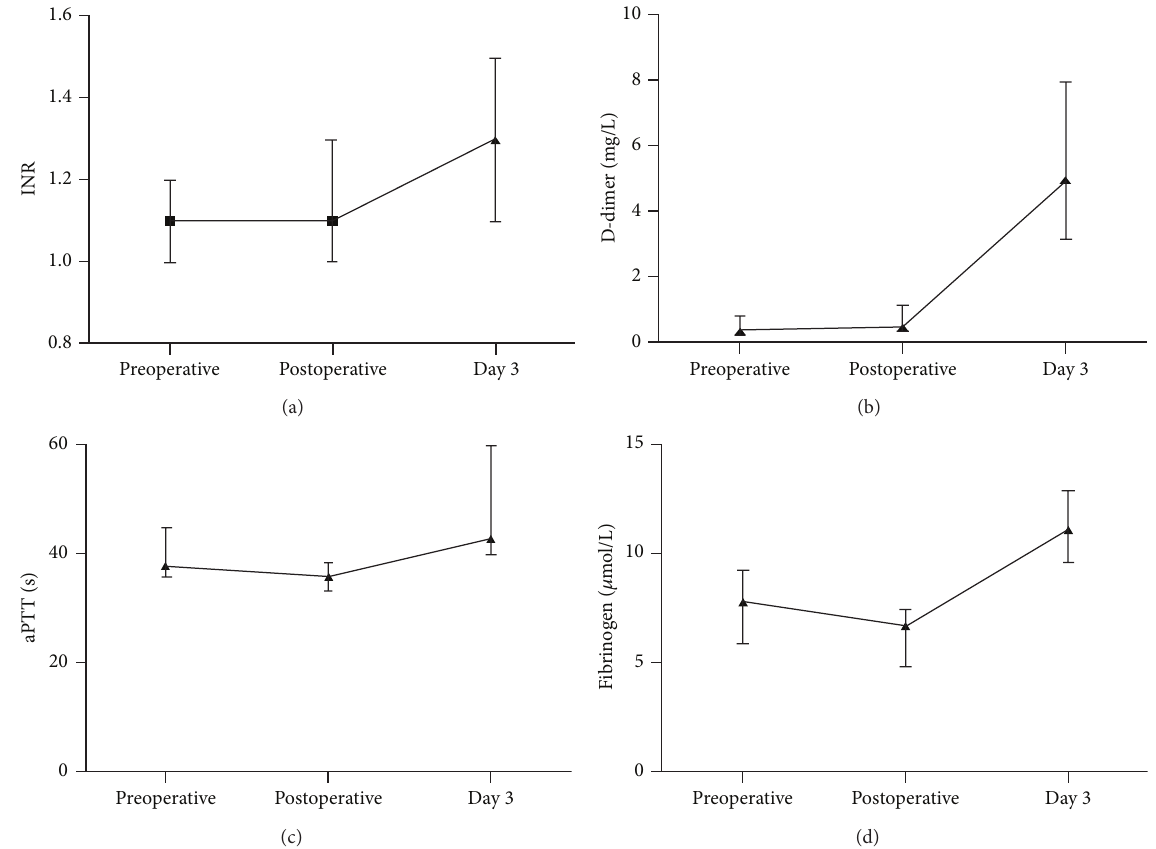
Figure 1: Pre- and postoperative values for coagulation parameters in the group undergoing major surgery. Values are medians and interquartile ranges (IQR). INR: international normalized ratio; aPTT: activated partial thromboplastin